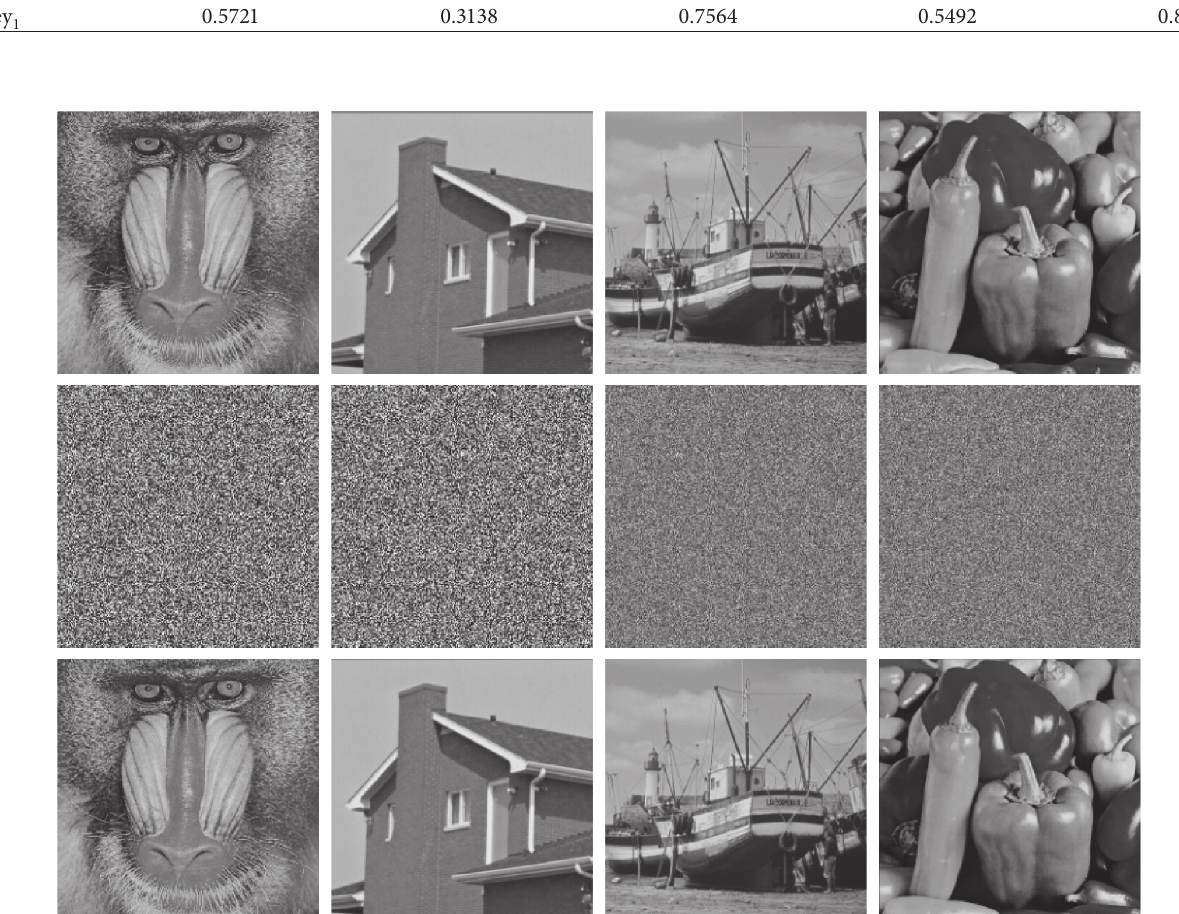
Figure 10: Encryption and decryption experiment result (from top to bottom: original image, encrypted image, and decrypted image, respectively).